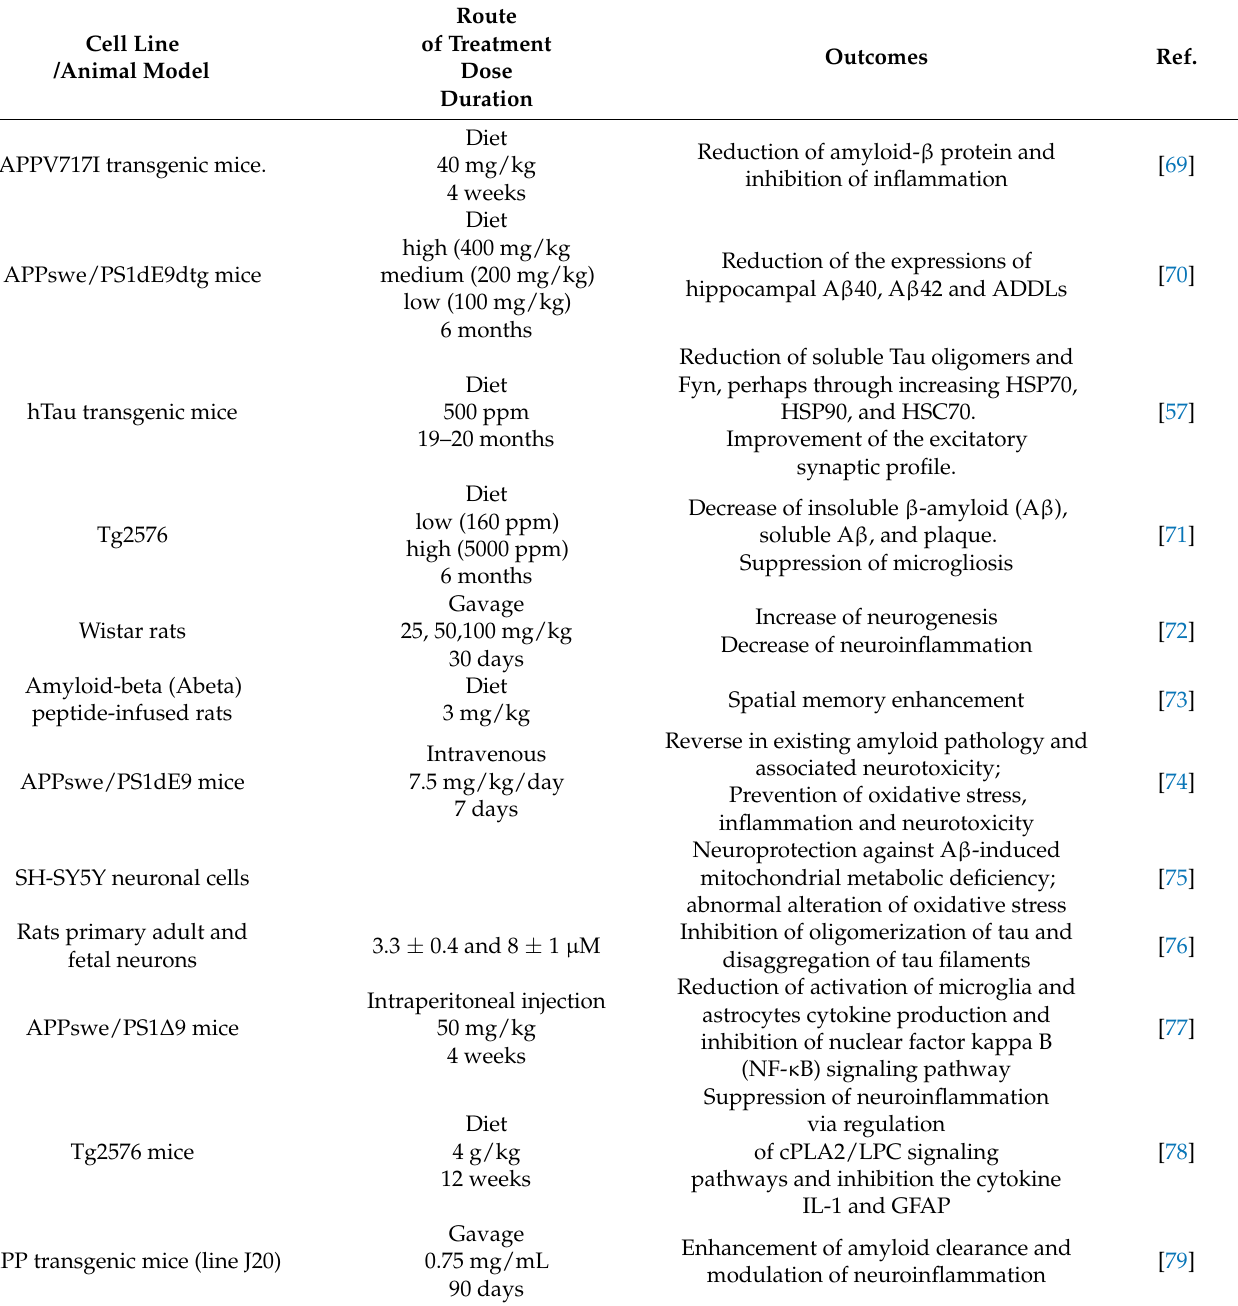
Table 2. In vitro and in vivo studies of curcumin on Alzheimer’s